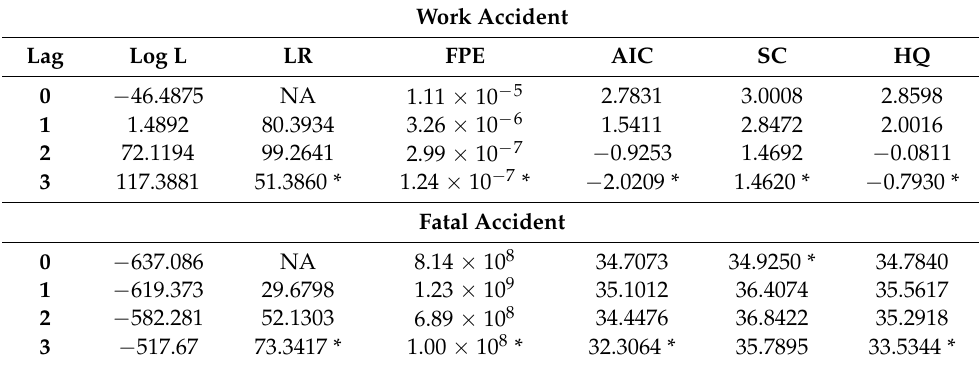
Table 3. VAR lag order selection